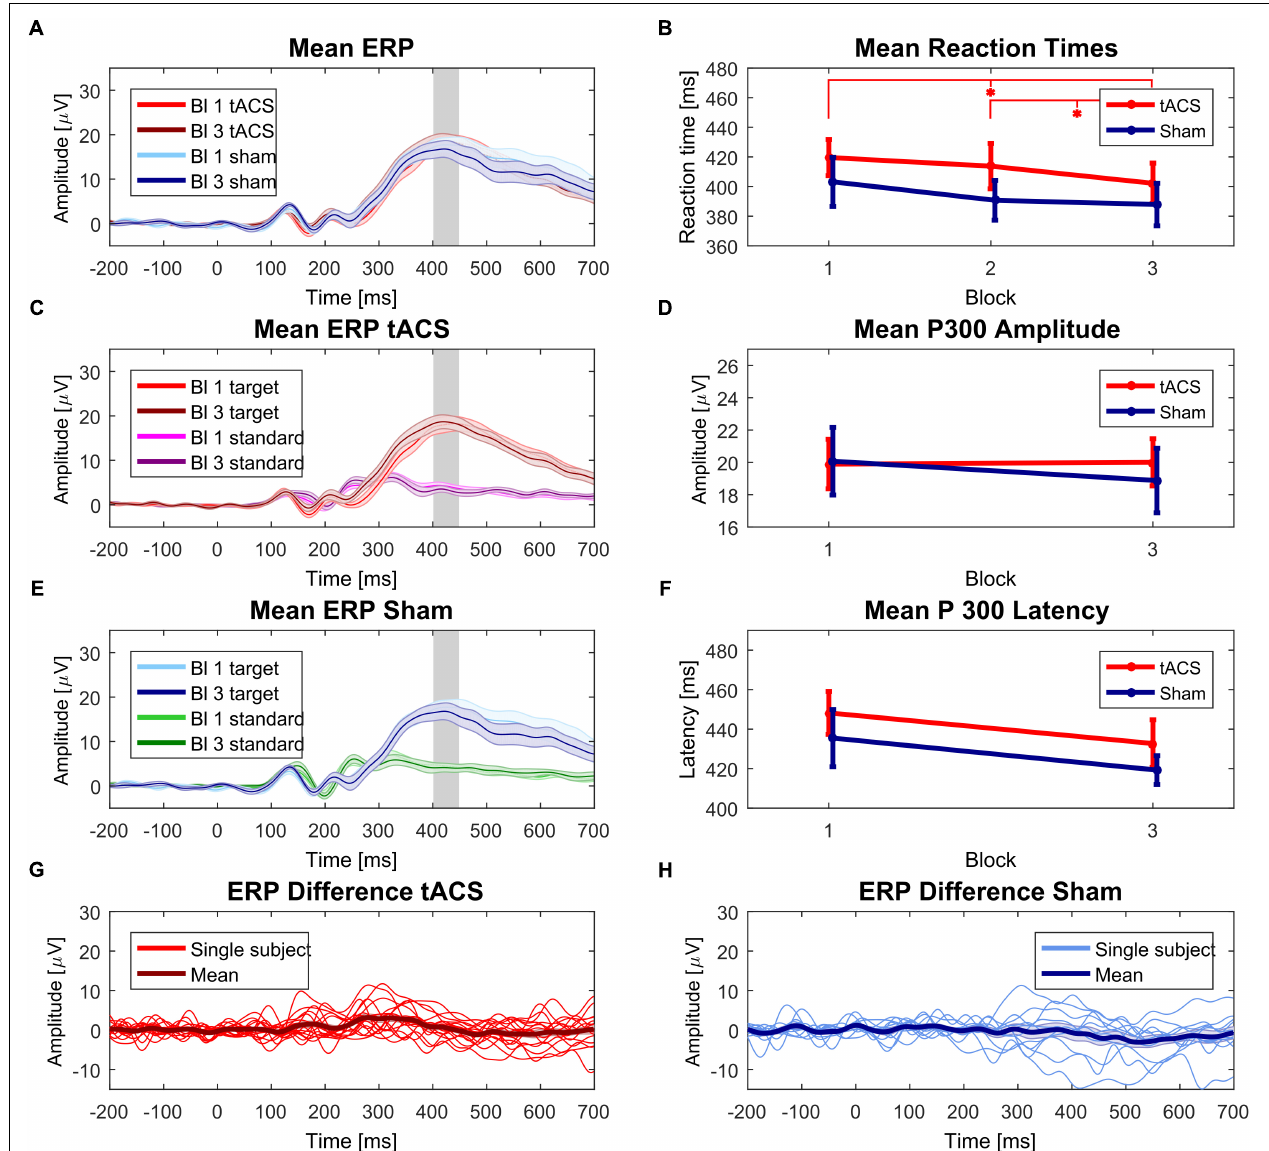
FIGURE 5 | Behavioral and EEG results. (A) Mean ERPs of tACS and sham group pre and post stimulation. Shaded areas and error bars in all plots depict the respective standard error of the mean. Gray rectangle in (A,C,E) indicates that amplitude comparison was performed at individual P300 amplitude peak. (B) Reaction times of tACS and sham condition for each experimental block (baseline, stimulation block and post stimulation block). Asterisks indicate p < 0.05 for one-sided paired sample t -tests between baseline and post-stimulation block and between stimulation block and post stimulation block of the tACS group. (C) Mean ERPs of tACS group before and after stimulation. Standard trials displayed for comparison. (D) Mean P300 amplitude of the tACS and sham group before and after stimulation. (E) Mean ERP of sham group before and after stimulation. Standard trials displayed for comparison. (F) Mean P300 latency of tACS and sham condition before and after stimulation. (G) Individual ERP differences (Block 3 – Block 1) of target trials of the tACS group. Positive values indicate amplitude increase after stimulation block. (H) Individual ERP differences (Block 3 – Block 1) of the sham